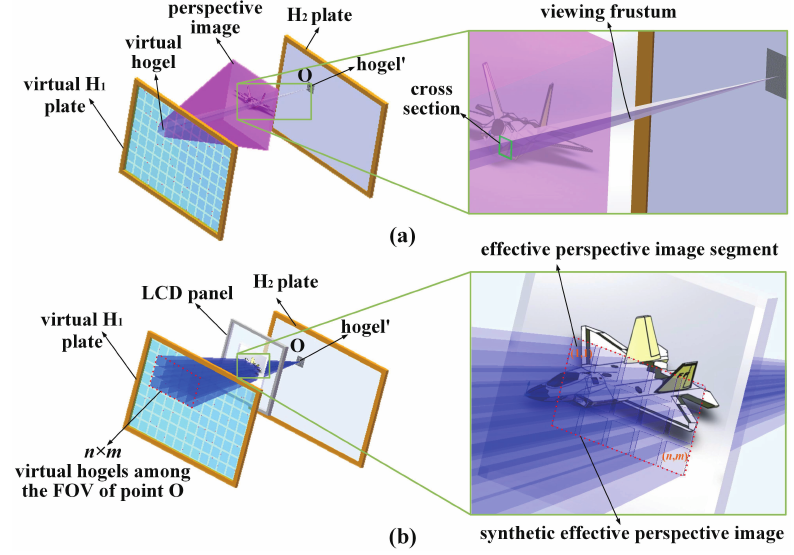
Figure 5. Principle of the effective perspective image segmentation and mosaicking (EPISM) method. ( a ) The extraction of effective perspective image segment corresponding to a single virtual hogel. ( b ) The synthetic effective perspective image mosaicked by effective images segments of multiple virtual hogels. (Reprinted with permission from ref [29],